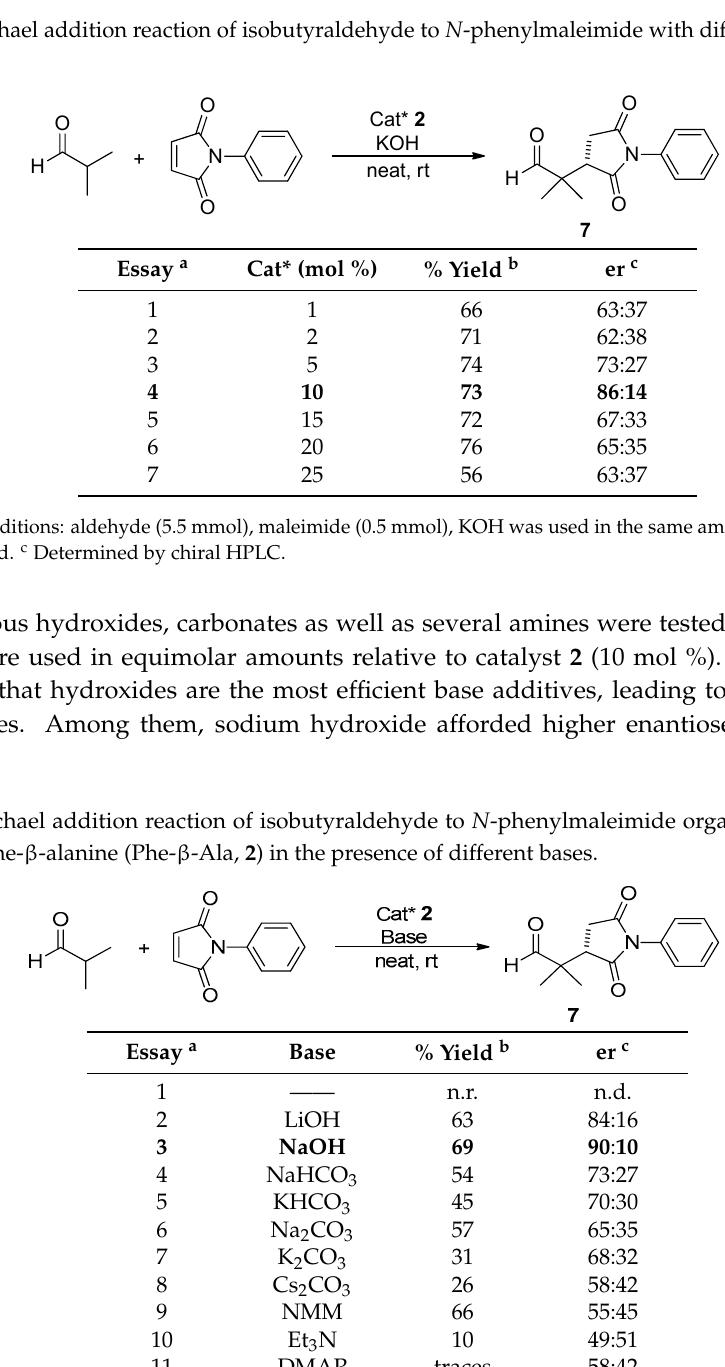
Table 2. Michael addition reaction of isobutyraldehyde to N -phenylmaleimide with different amounts of catalyst.